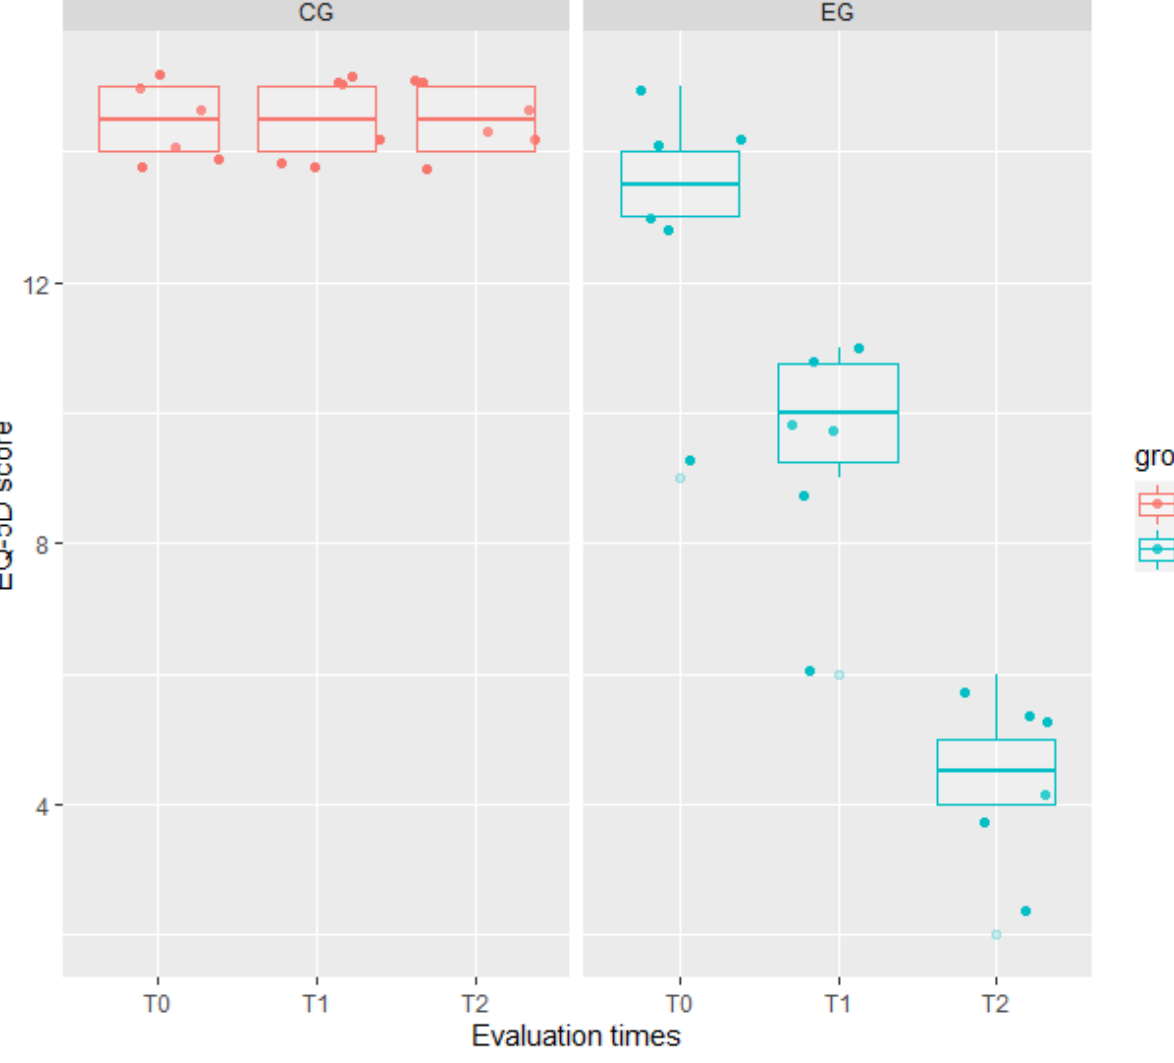
Figure 1. Comparison of quality of life scores (measured by EQ-5D = EuroQol-5D scale) between the experimental group (EG) in green, and the control group (CG) in red, at any evaluation time (T0, T1, and T2). Any box represents data distribution: the bounds at the top and bottom are the first and third quartiles, the center line is the median value, the whiskers from the box indicate the minimum and maximum values, dark (jittered) points represent patient EQ ‐ 5D scores, while clear points represent outliers. CG boxplots are similar among evaluation times, while EG boxplots show a significant decrease from T0 to T2.